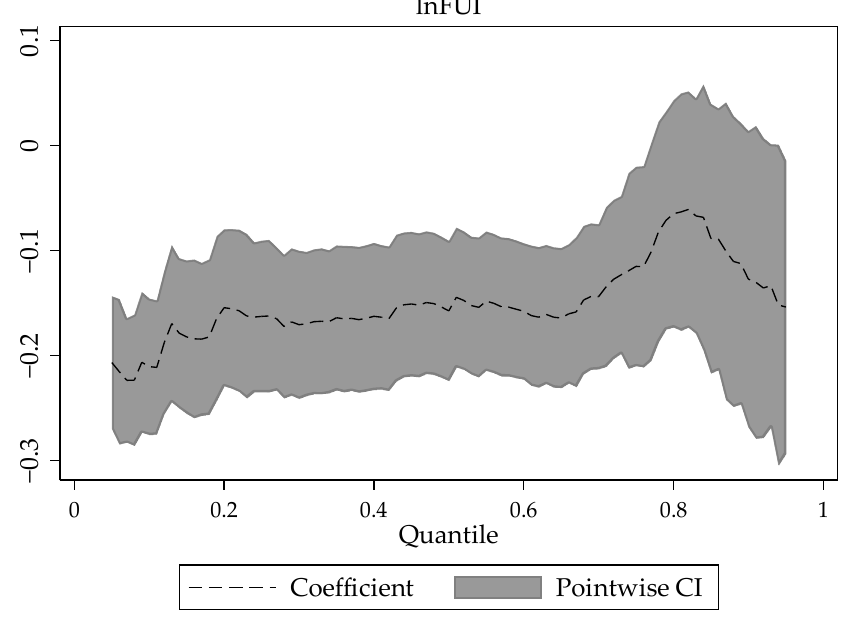
Figure 3. The trend of the estimated coefficient of FUI.